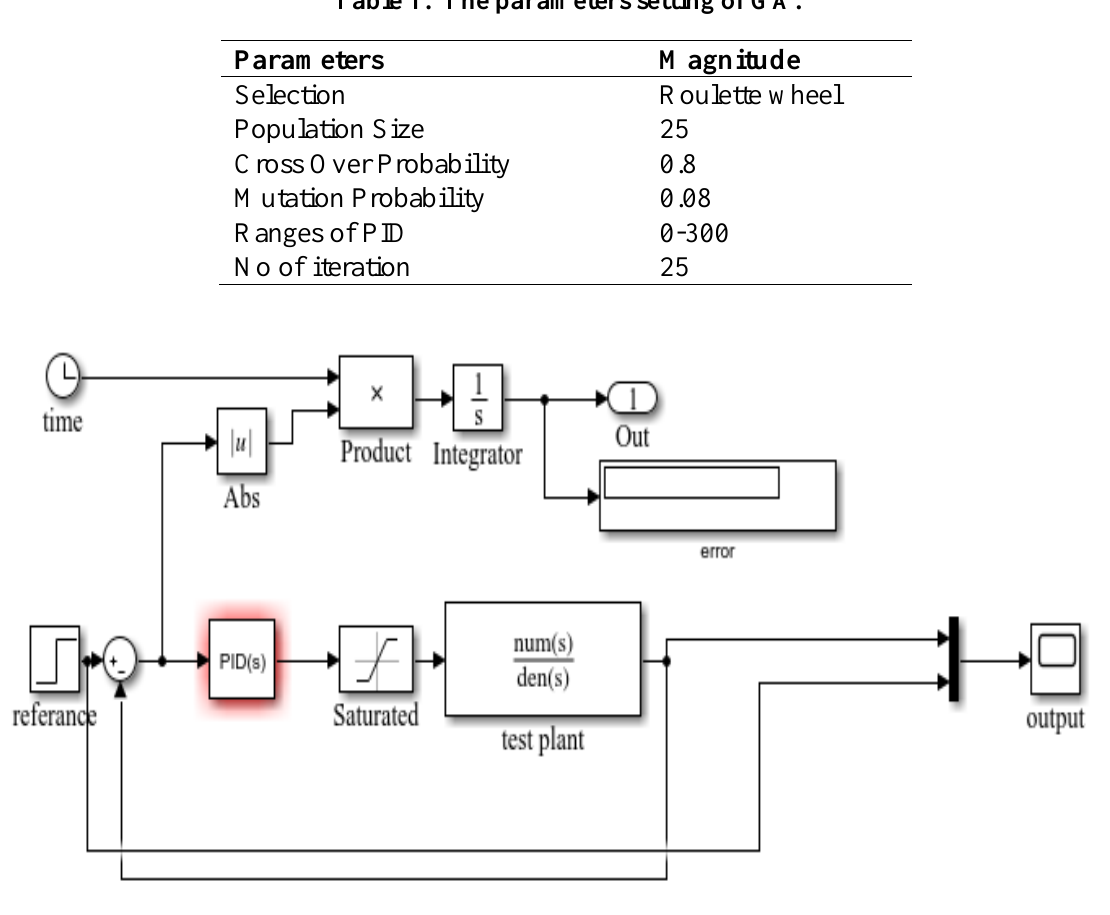
Table 1. The parameters setting of GA.